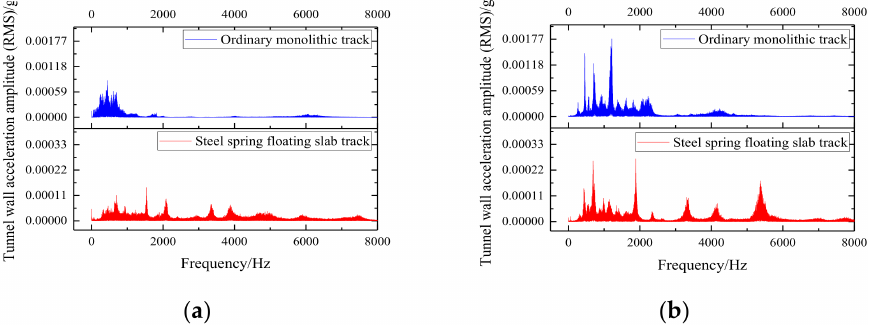
Figure 15. Comparison of vertical frequency spectrum of tunnel wall. ( a ) Straight line segment; ( b ) curved